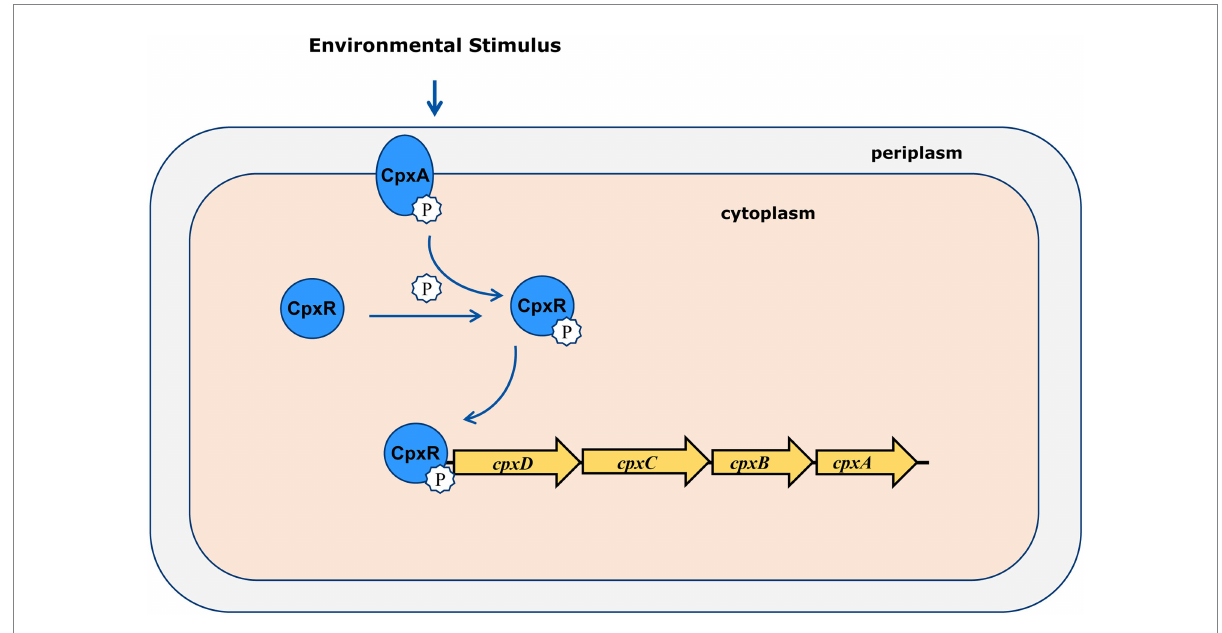
FIGURE 5 Molecular model of virulence regulation by CpxAR. CpxDCBA transcription is activated by CpxR-P, which contributes to the virulence in A. pleuropneumoniae